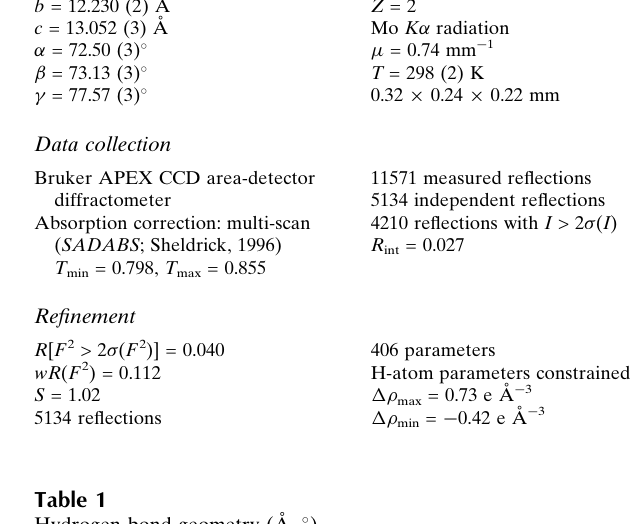
Hydrogen-bond geometry (A˚ , (cid:2)